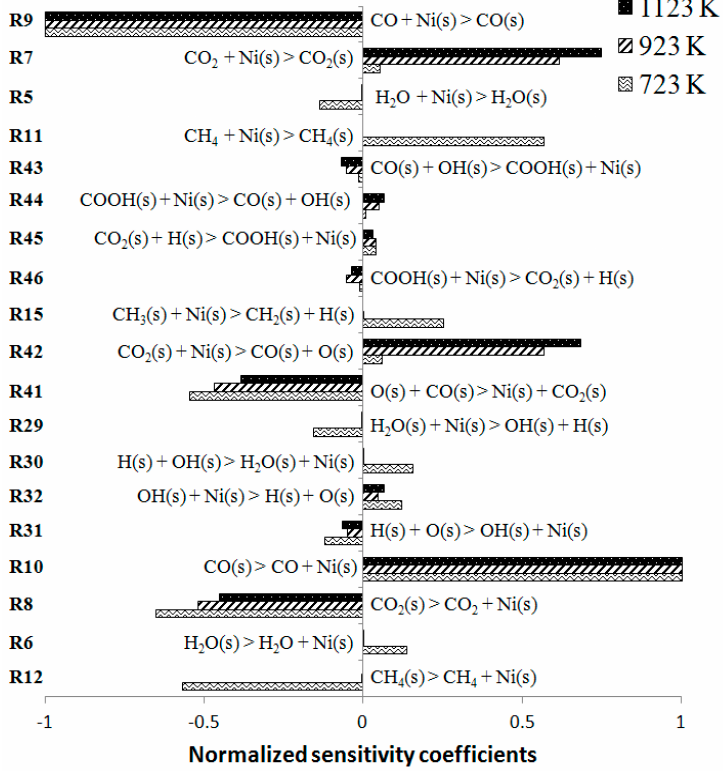
Figure 9. Sensitivity analysis of CO gas-phase concentration for steam reforming methane at different temperatures for CH 4 /H 2 O = 0.8 and 1